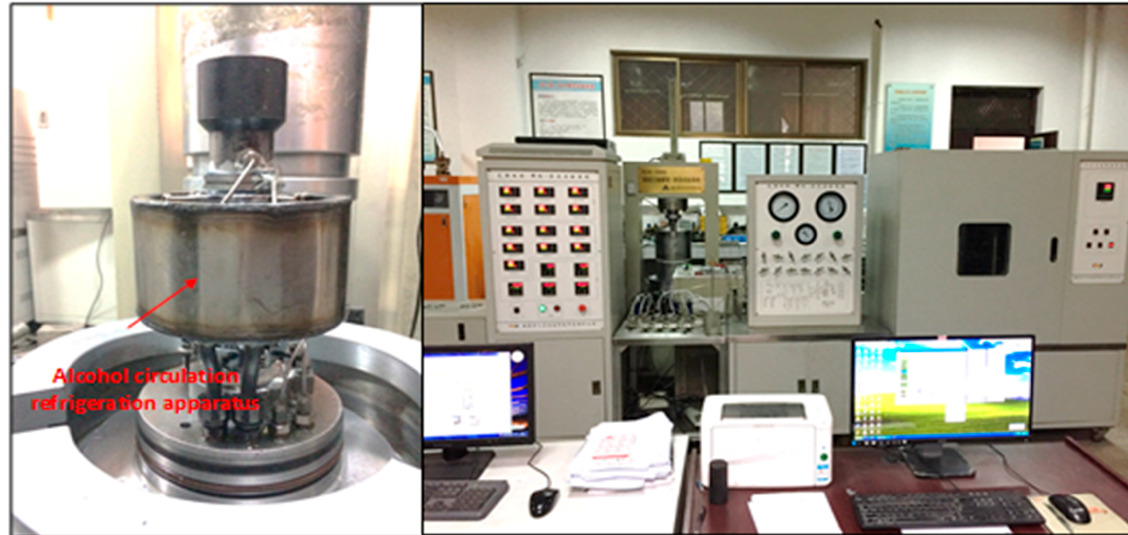
Figure 3. The physical diagram of the alcohol circulating refrigeration apparatus in the coal sample chamber and the tri-axial creep-seepage and adsorption-desorption experimental systems of coal and rock: 1-high-pressure gas tank group; 2-pressure regulating valve; 3-vacuum pumping device; 4-temperature control device, mainly including ethanol circulating refrigeration device and electric heating device; 5–reference tank group, system transfer gas supply device; 6-standard tank group, system calibration gas supply device (He); 7-coal sample chamber, sample loading and fixture device; 8-sample, this time is coal sample; 9-axial stress loading servo control device; 10-radial stress loading servo control device; 11-pore pressure servo control device; 12-system exhaust device; 13-gas flow meter group; 14-the alcohol circulating refrigeration apparatus; F-air valve; P-pressure sensor; T-Temperature sensor; Z-gas booster device.